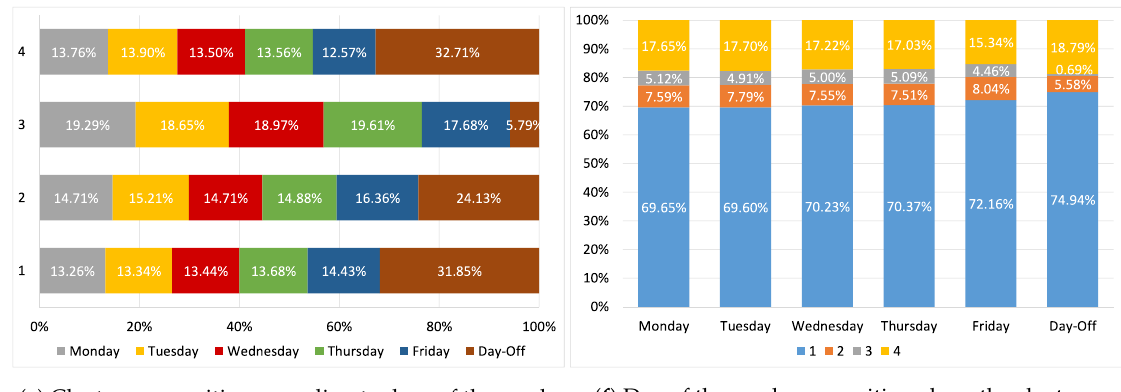
Figure 5. Cluster analysis depending on buildings, seasons of the year and days of the